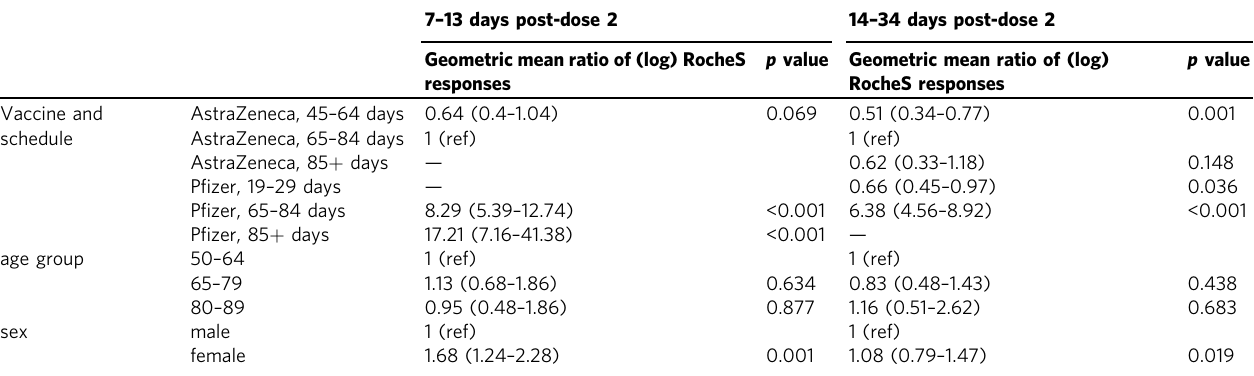
Table 4 Adjusted models at two timepoints post-dose 2, using AZ 65 – 84 day schedule group as reference. P values relate to two-sided z-tests of log(GMR) =